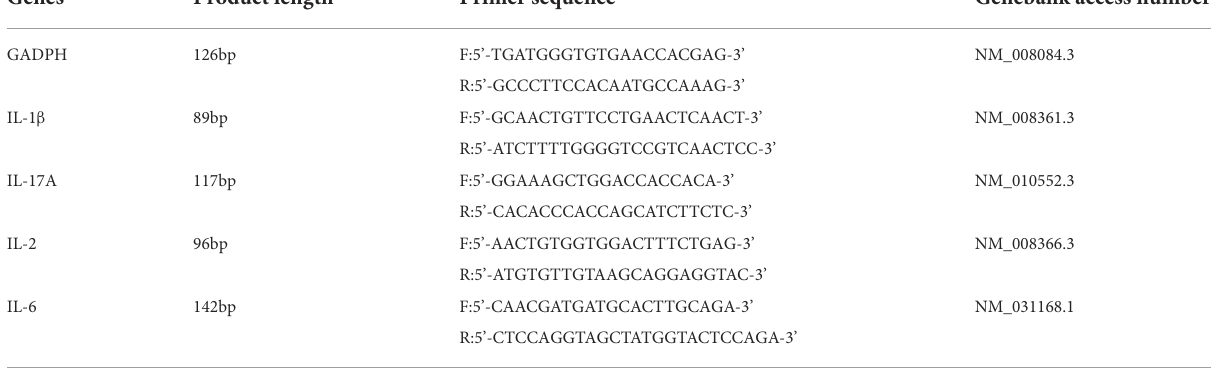
TABLE 1 The PCR primer sequences for amplifying GADPH, IL-1 β , IL-17A, IL-2 and IL-6.